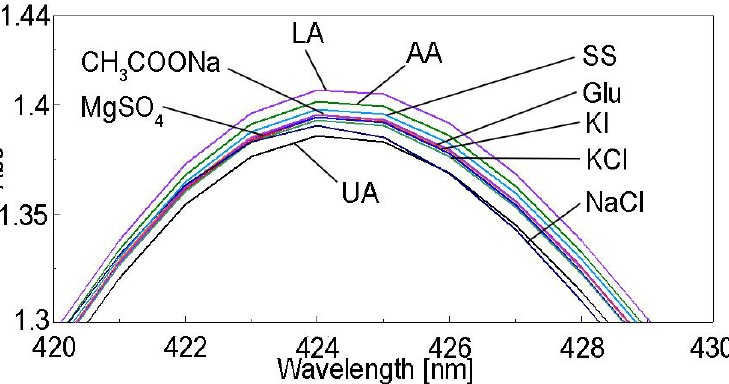
Figure 13. Overlapped UV-Vis spectra representing the influence of diverse interfering species (at concentrations 1000-fold higher than UA) on the TAmPP material: glucose (Glu), ascorbic acid (AA), NaCl, KCl, CH 3 COONa, MgSO 4 , KI, lactic acid (LA), and sodium salicylate (SS).